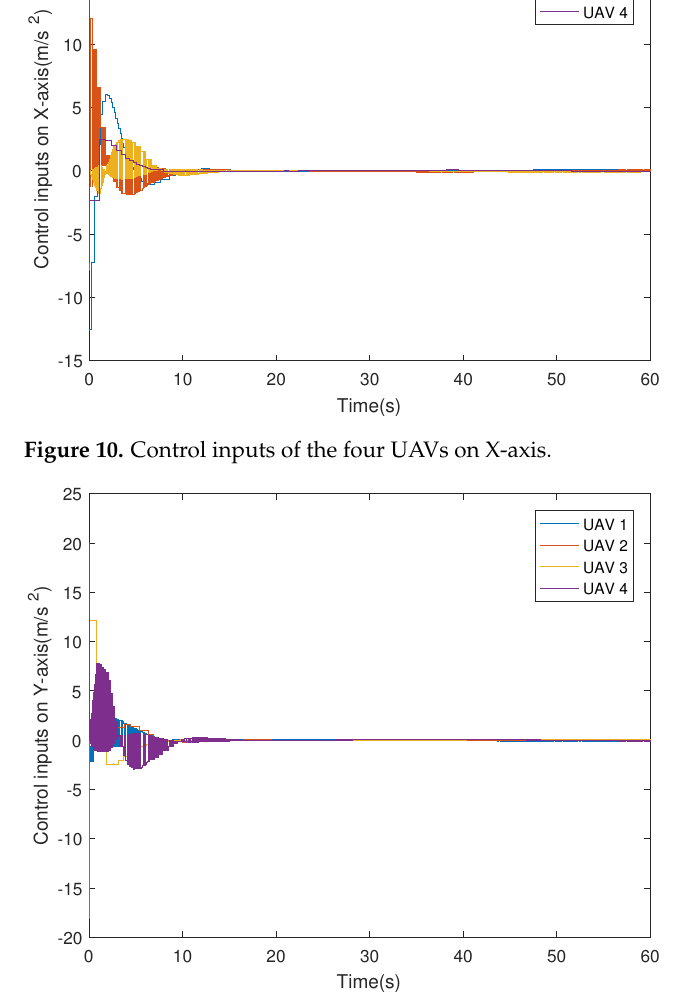
Figure 11. Control inputs of the four UAVs on